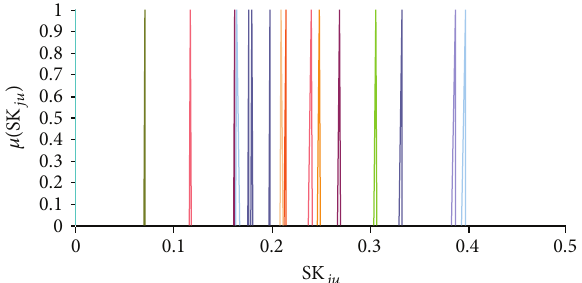
FFSVCT: 7 → 13 → 19 → 16 → 11 → 1 → 6 → 4 → 9 → 15 → 17 → 8 → 3 → 12 → 2 → 14 → 18 → 5 → 10 .